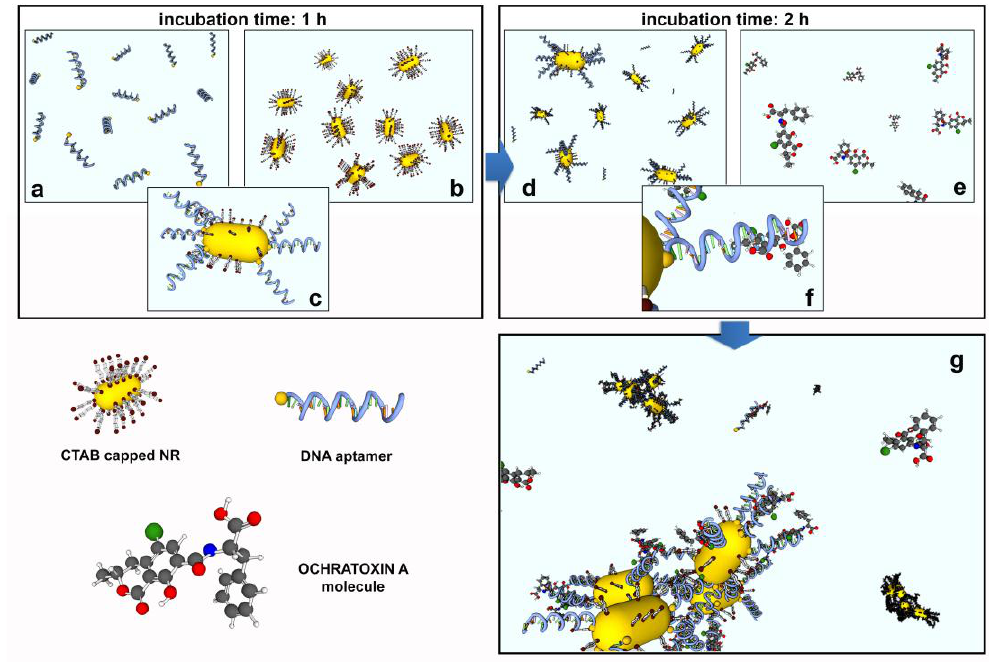
Figure 9. Functionalization process: ( a ) ssDNA aptamer solution is mixed with ( b ) gold NRs in the volume proportion 1:3. After the system has incubated for 1 h, the aptamer functionalized NRs ( c , d ) are mixed with the OTA molecules ( e ) in the volume proportion 3:1. The system is left to incubate for about 2 h to allow the interaction between DNA aptamers and molecules ( f ) for the formation of the NR complexes ( g ).